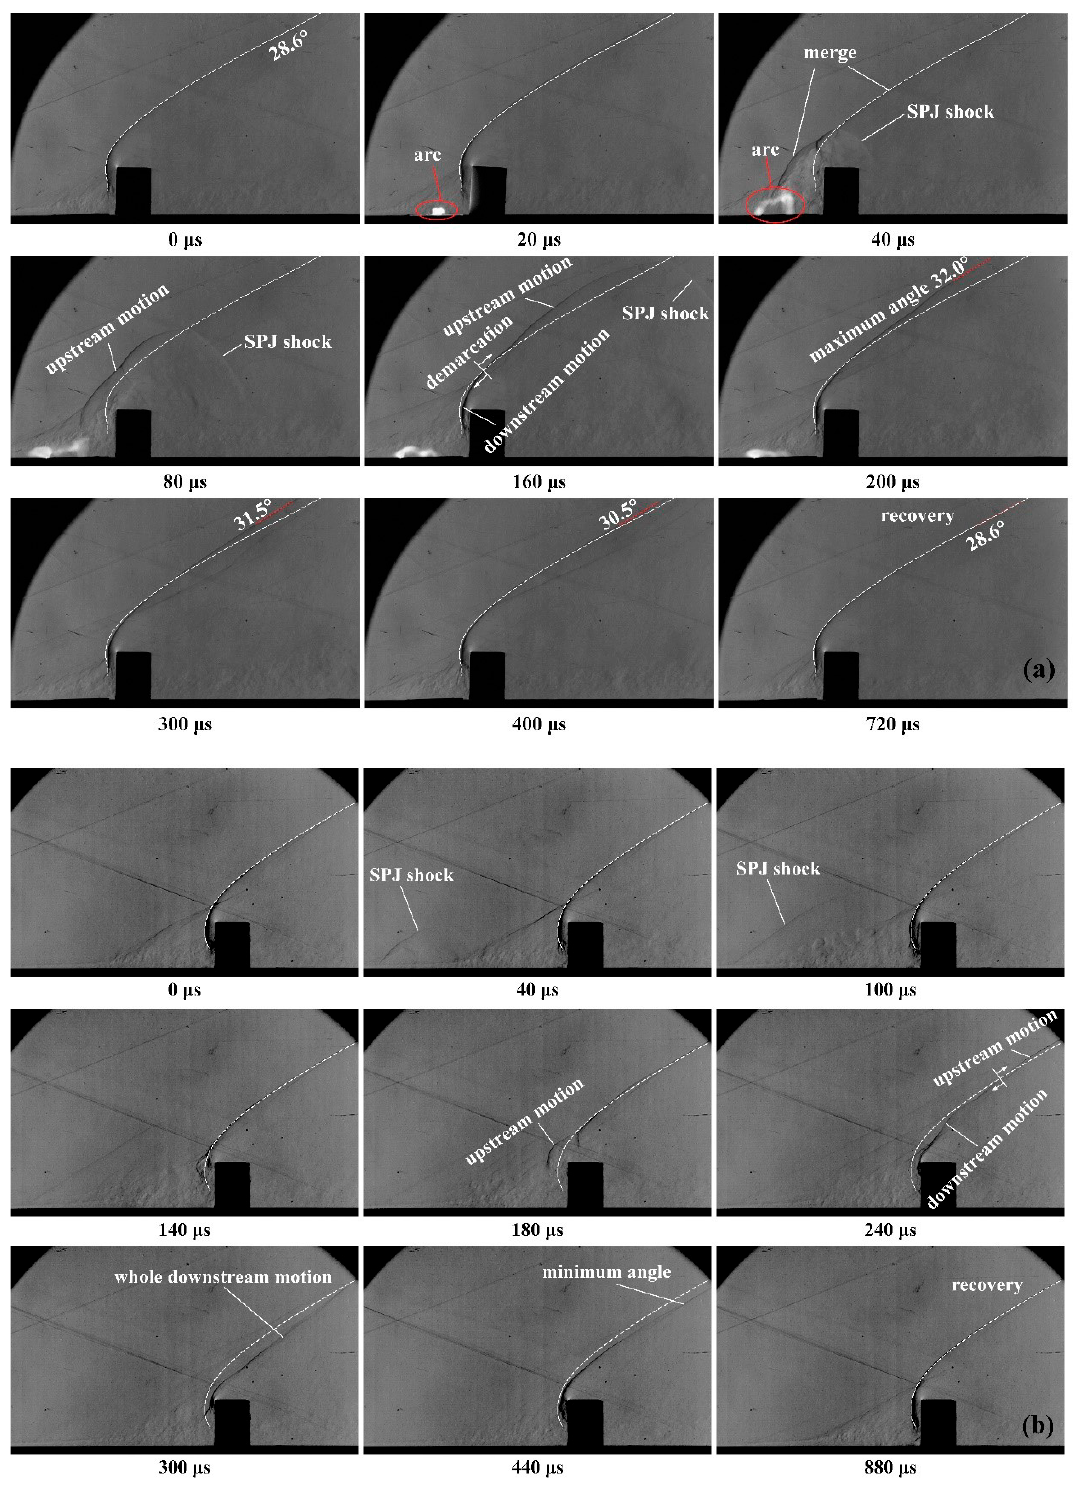
Figure 10. Comparison of the flow field evolution process when SPJ exit is in the separation zone and outside: ( a ) case7—in the separation zone, ( b ) case5—outside the separation zone.